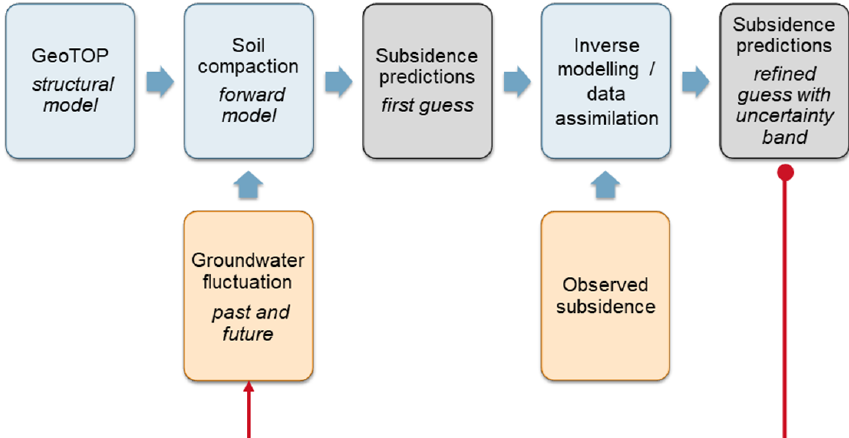
Figure 2. Overview of the main steps of the workflow for shallow subsidence